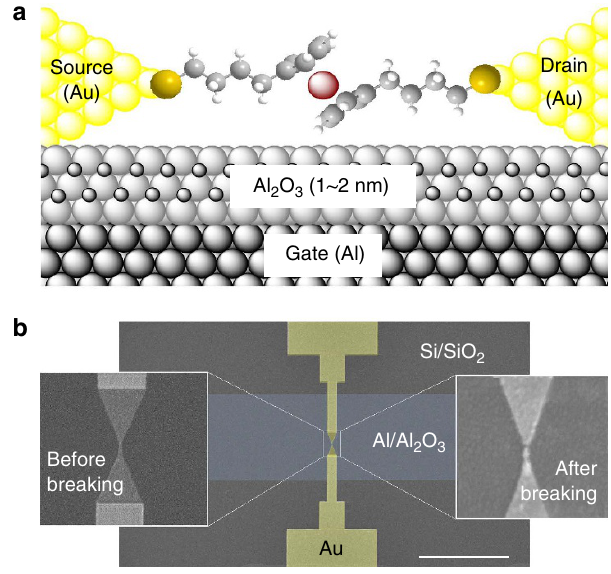
Figure 1 | The single molecule junctions. ( a ) Schematic of a S-(CH 2 ) 4 -Fc- (CH 2 ) 4 -S molecule bridging the nanogap between the two bias leads of a SET. ( b ) False colour scanning electron microscopy (SEM) image of one of our SETs showing the gold nanowire on the Al/Al 2 O 3 back gate. The scale bar is 10 m m. The insets show the thinnest part of nanowire before and after the feedback-controlled electromigration-induced breaking. The molecule completes the device by bridging the resulting nanogap during deposition from solution. NATURE COMMUNICATIONS|7:11595|DOI: